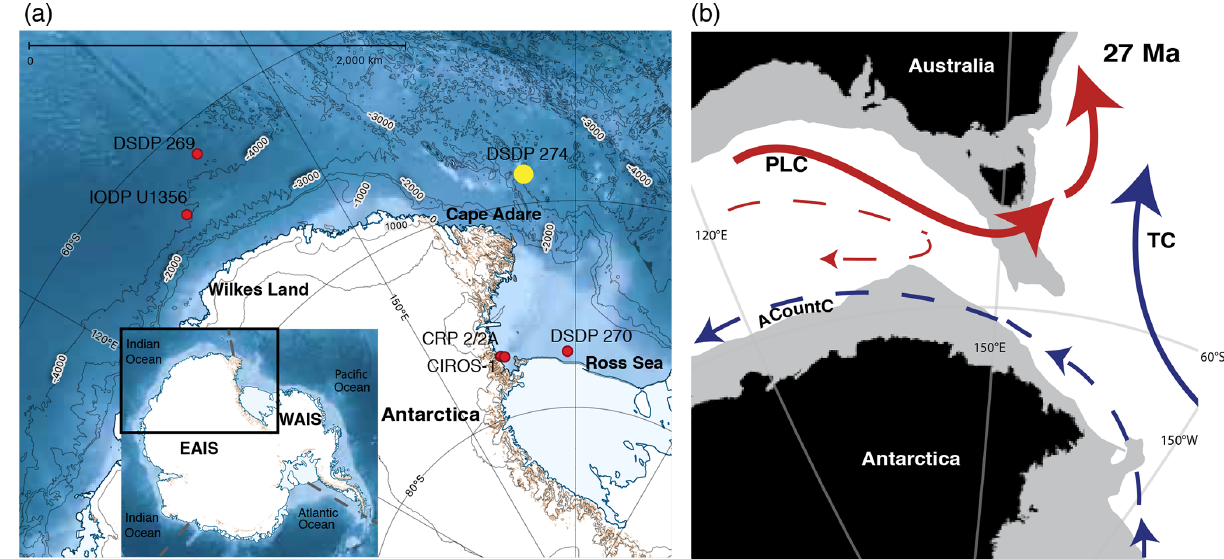
Figure 1. (a) Ross Sea to Wilkes Land margin bathymetry with present-day locations of the DSDP, IODP and CRP drill sites included in this study (red dots). The new data generated for this study are from DSDP Site 274 (yellow dot). The base map is from the Quantarctica GIS package (Norwegian Polar Institute). The inset shows the Antarctic continent and the surrounding oceans (divided by grey dotted lines) to give a broader regional context to the study area. (b) A synthesis of palaeoceanographic settings at 27Ma. The palaeogeographic position is generated with GPlates (http://www.gplates.org, last access: 13 June 2016), based on the global plates geodynamic motion model from Müller et al. (2018). Light grey indicates the continental lithosphere. The inferred ocean currents are drawn after reconstructions by Stickley et al. (2004); the abbreviation used are as follows: TC is the Tasman Current, PLC is the proto-Leeuwin Current and ACountC is the Antarctic Counter Current. Blue arrows indicate cooler ocean currents, and red arrows indicate warmer ocean currents. Relative current strength is indicated by the arrow